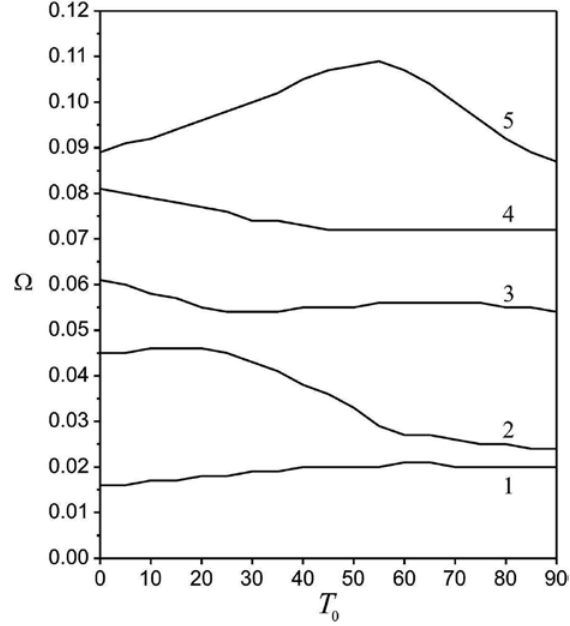
Figure 14: Frequency parameter Ω versus T five modes of the soft simply supported graphite/epoxy [  〈 T circular laminate.